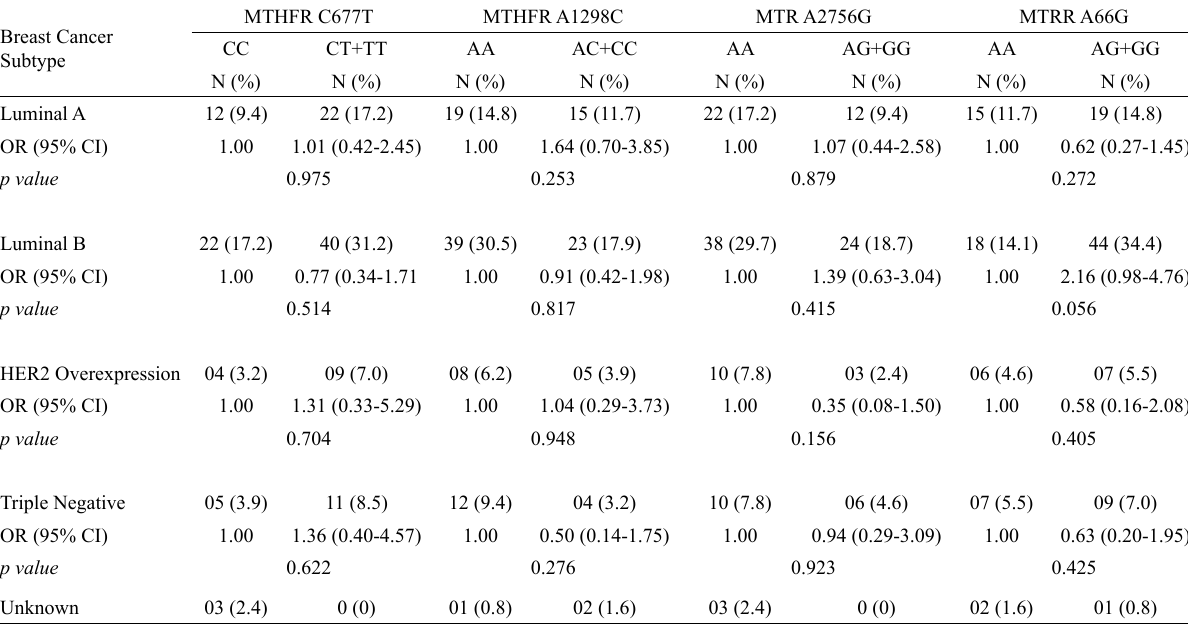
Table 3 ‒ Association between MTHFR C677T, MTHFR A1298C, MTR A2756G and MTRR A66G polymorphisms and breast cancer